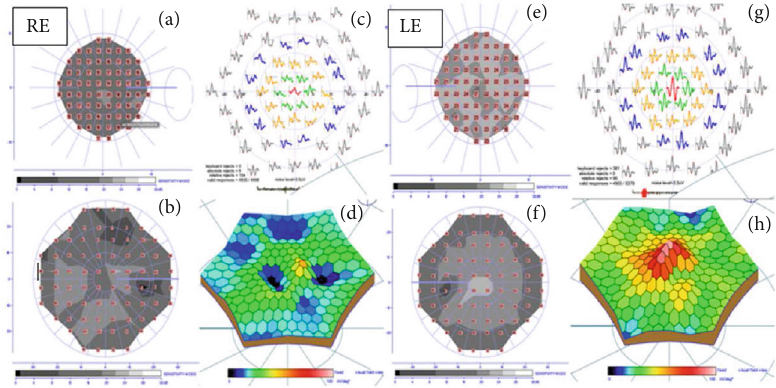
Figure 5: Comparative campimetric and multifocal electroretinography (mfERG). Right eye (a) 10-2 and (b) 30-2 visual fi eld view testing show de fi cits in retinal sensitivity to the central points of the stimuli. The mean de fi cits are 9.0 and 7.8dB, respectively, compared with the contralateral normal eye (normal mean de fi cit: 0.5-2.0dB). (c) Subnormal retinal response and reduction of the N1 and P1 wave amplitudes. The 61-hexagon 30 ° test had decreased by 75.0%, 41.9%, 27.0%, 10.5%, and 6.15%, respectively, from the < 2-degree to > 15- degree central rings compared to the normal control parameters (normal range of the mean de fi cit permitted is 1-3%). (d) mfERG as a 3- D topographic fi eld map of the macular function shows subnormal foveal photoreceptor sensitivity with a normal spatial resolution, due to stable fi xation and location pattern. Left eyes comparative normal fi gures of the left eye show (e) 10-2, (f) 30-2, and (g, h) mfERG within the normal range.